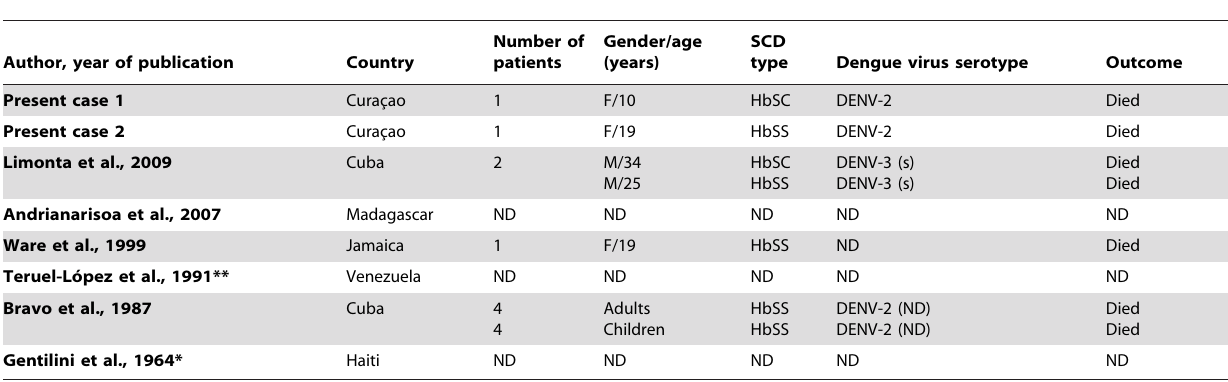
Table 1. Summary of literature